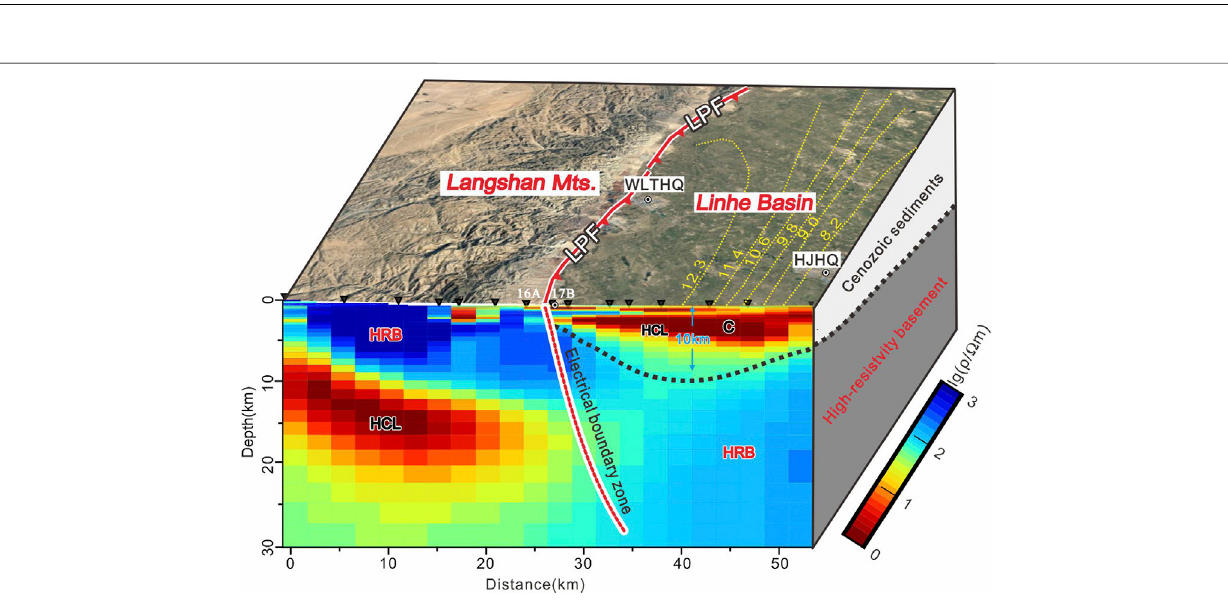
Frontiers in Earth Science |